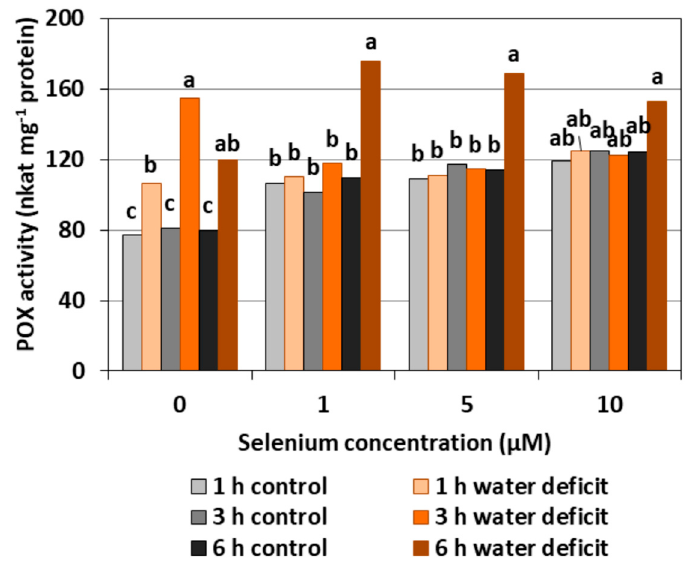
Figure 5. The peroxidase (POX) activity in the roots of cucumber seedlings pre-treated with Se and subjected to a WD. Bars marked with the same letters do not differ significantly at p < 0.05.